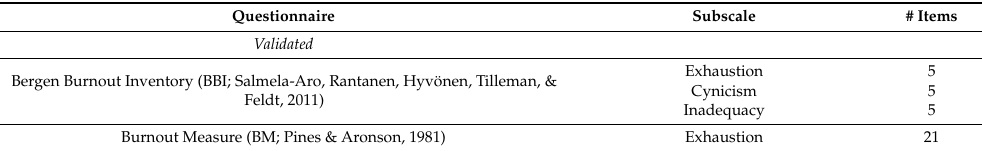
Table A1. Burnout